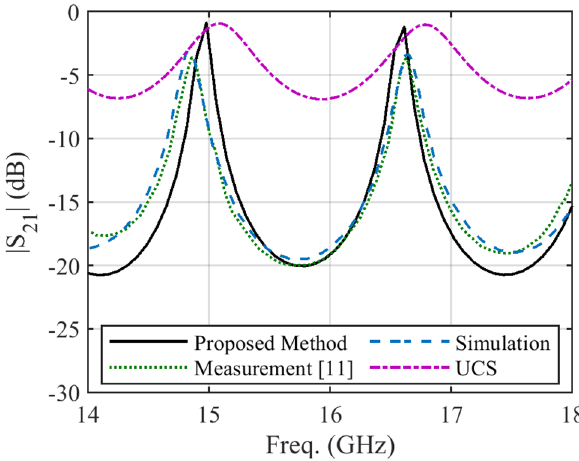
Figure 11. Magnitude of S 21 of the linearly-tapered SIW.